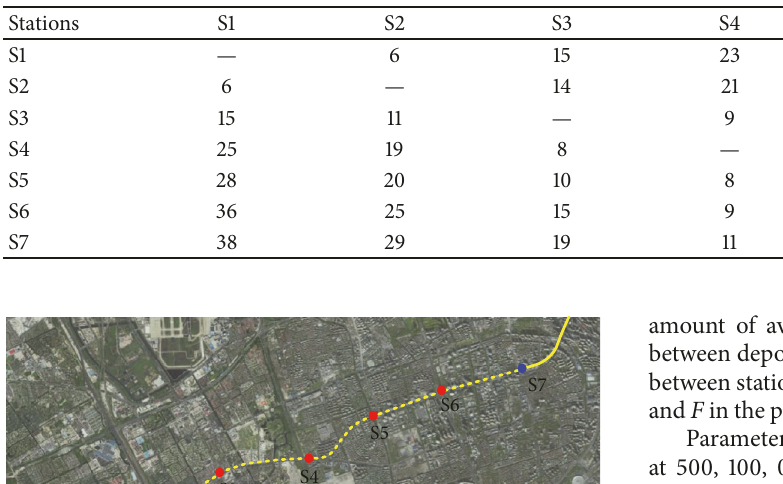
Table 4: Travel time between stations in the numerical case (units: min).